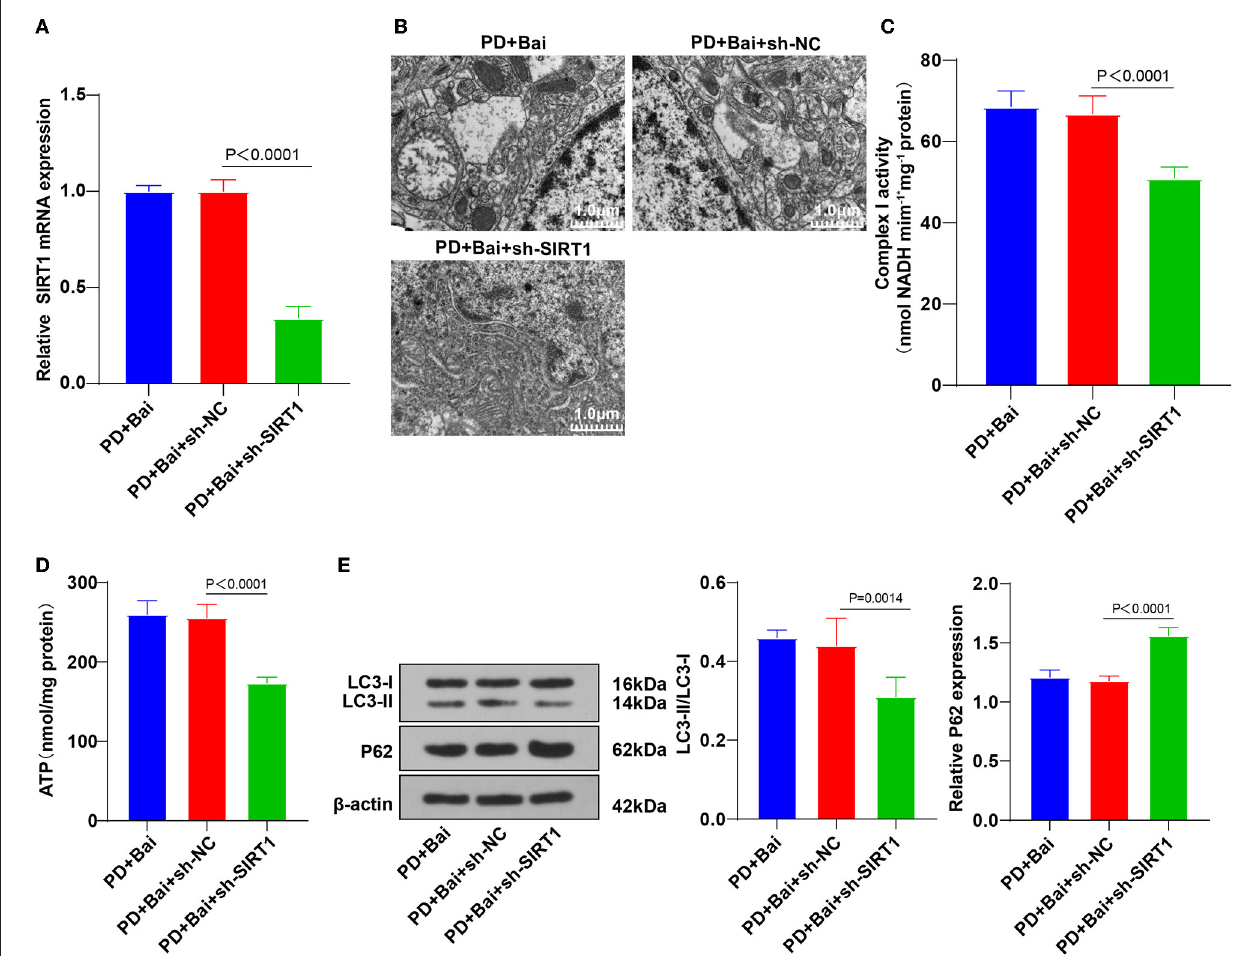
FIGURE 4 | Downregulation of SIRT1 reversed baicalein-induced mitochondrial autophagy. The effect of SIRT1 on baicalein-induced mitochondrial autophagy was observed by inhibiting the expression of SIRT1 in PD rats by sh-SIRT1. (A) The expression of SIRT1 was detected by RT-qPCR; (B) the ultrastructure of mitochondria was observed using a TEM; (C,D) the activities of mitochondrial complex I and ATP were detected using kits; (E) the levels of autophagy marker proteins LC3-II/I and p62 were detected by WB. N = 6. The data in the figure are all measurement data and expressed as mean ± standard deviation; one-way ANOVA was used for variance analysis among multigroups; Tukey’s multiple comparisons test was used for the post hoc